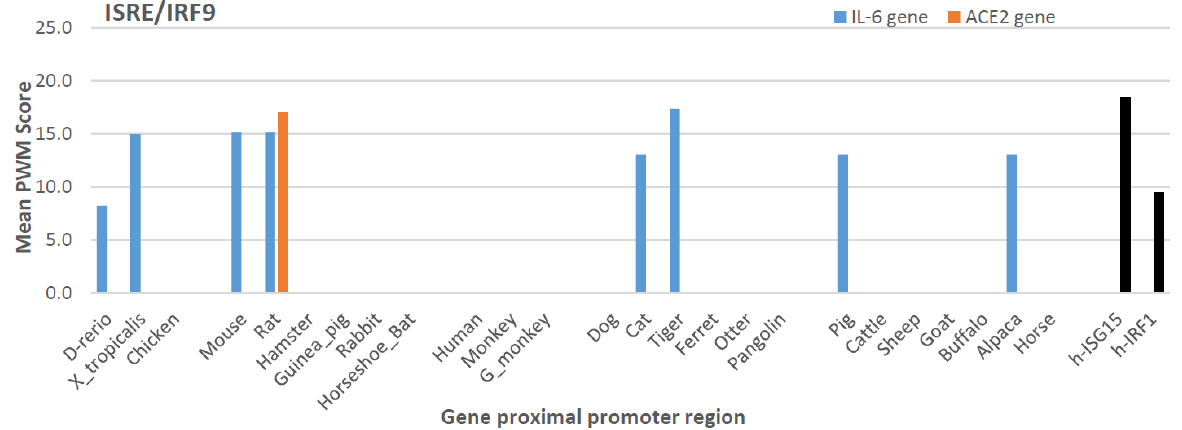
Figure 4. Lack of ISRE/IRF9 binding site that responds to IFN signaling for ISG expression in analyzed IL-6 and ACE2 genes. Cross-species analysis of mean PWM (mPWM) scores of cis -regulatory elements (CREs) that bind ISRE/IRF9 in the proximal promoter regions of IL-6 and ACE2 gene orthologs from the 25 representative vertebrate species. mPWM score is presented in a Log2(mPWM) scale. It further indicates that IL-6 and especially ACE2 genes in most species are non-ISGs. Canonical ISGs of human ISG15 and IRF1 are used as references (black bars). mPWM scores were calculated using tools at https://ccg.epfl.ch/pwmtools/pwmscore.php with CRE matrices from MEME-derived HOCOMOCOv11 TF collection affiliated with the PWM tools. PWM, position weight matrix. Abbreviations: D-rerio, Danio rerio (Zebrafish); X_trapicalis, Xenopus trapicalis; G_monkey, African Green Monkey; h-, human.